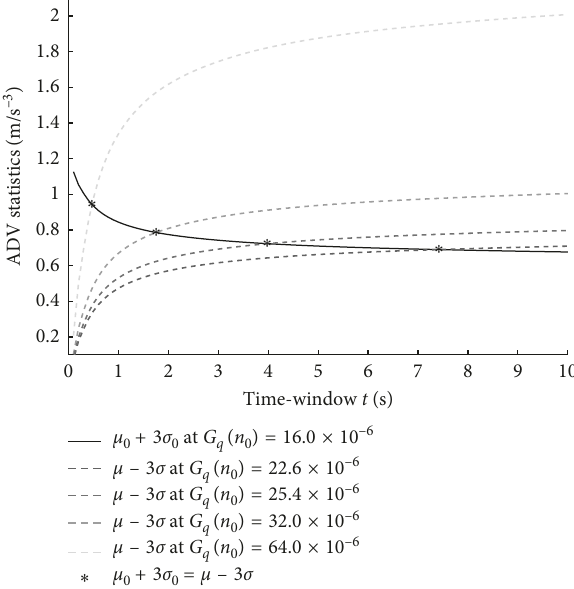
Figure 8: The results of minimum time-window length selection. Figure 7: Judgment of systems with different time-window while